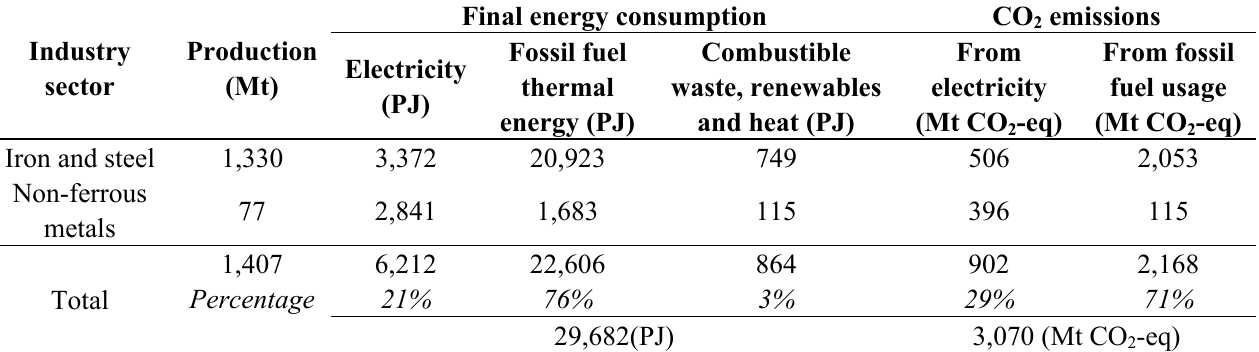
Table 3. Current energy usage and emissions in the metals industries